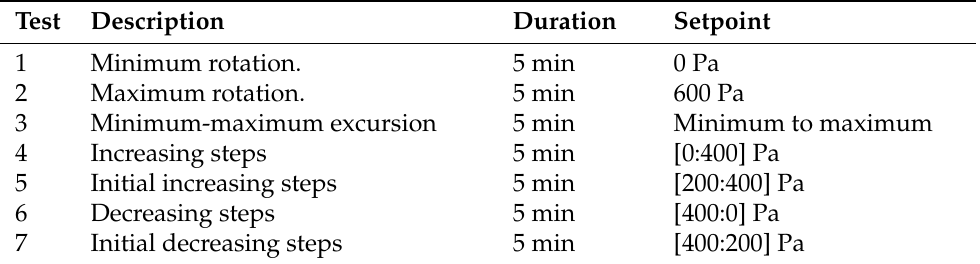
Table 3. Fan system schedule tests.